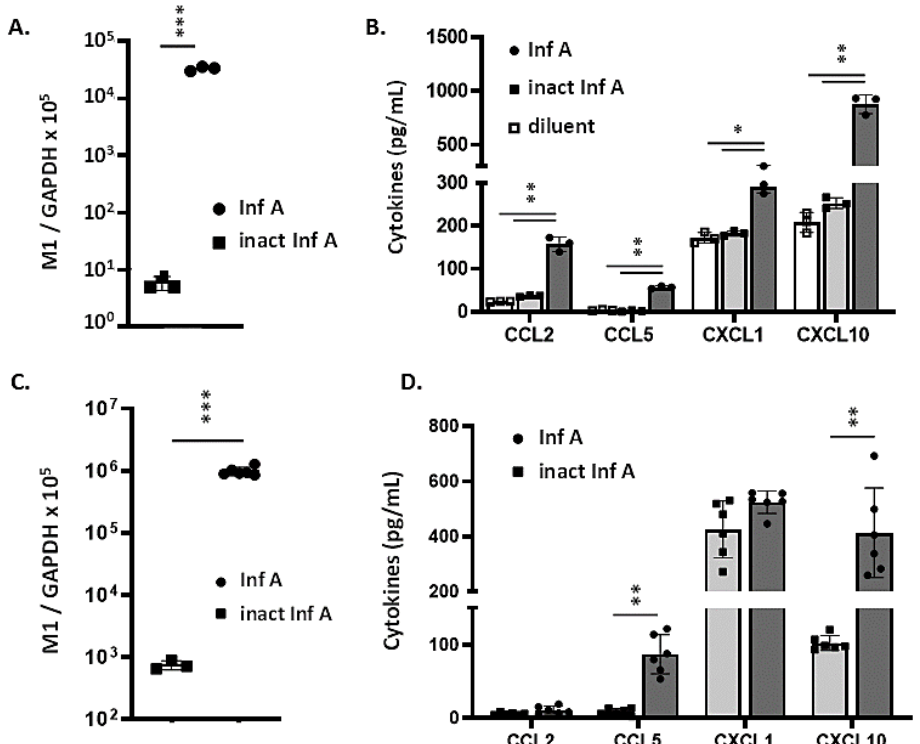
Figure 2. MLE-12 cells and mouse tracheal epithelial cells (mTECs) support replication of Inf A and produce proinflammatory cytokines in response to infection. ( A ) Virus detected in MLE-12 cells at 48 h after inoculation with live or heat-inactivated Inf A (4 h, 32 ◦ C, MOI = 0.5); *** p < 0.001, Mann–Whitney U-test. ( B ) MLE-12 cells infected with live Inf A produce and release proinflammatory cytokines, including CCL2, CCL5, CXCL10, and CXCL1, as shown; * p < 0.05, ** p < 0.01, one-way ANOVA. ( C ) Virus detected in mTECs at 48 h after inoculation with live or heat-inactivated Inf A; *** p < 0.001, Mann–Whitney U-test. ( D ) mTECs infected with live Inf A produce and release proinflammatory cytokines, including CCL5 and CXCL10, but not CCL2 or CXCL1, as shown; ** p < 0.01, one-way ANOVA.